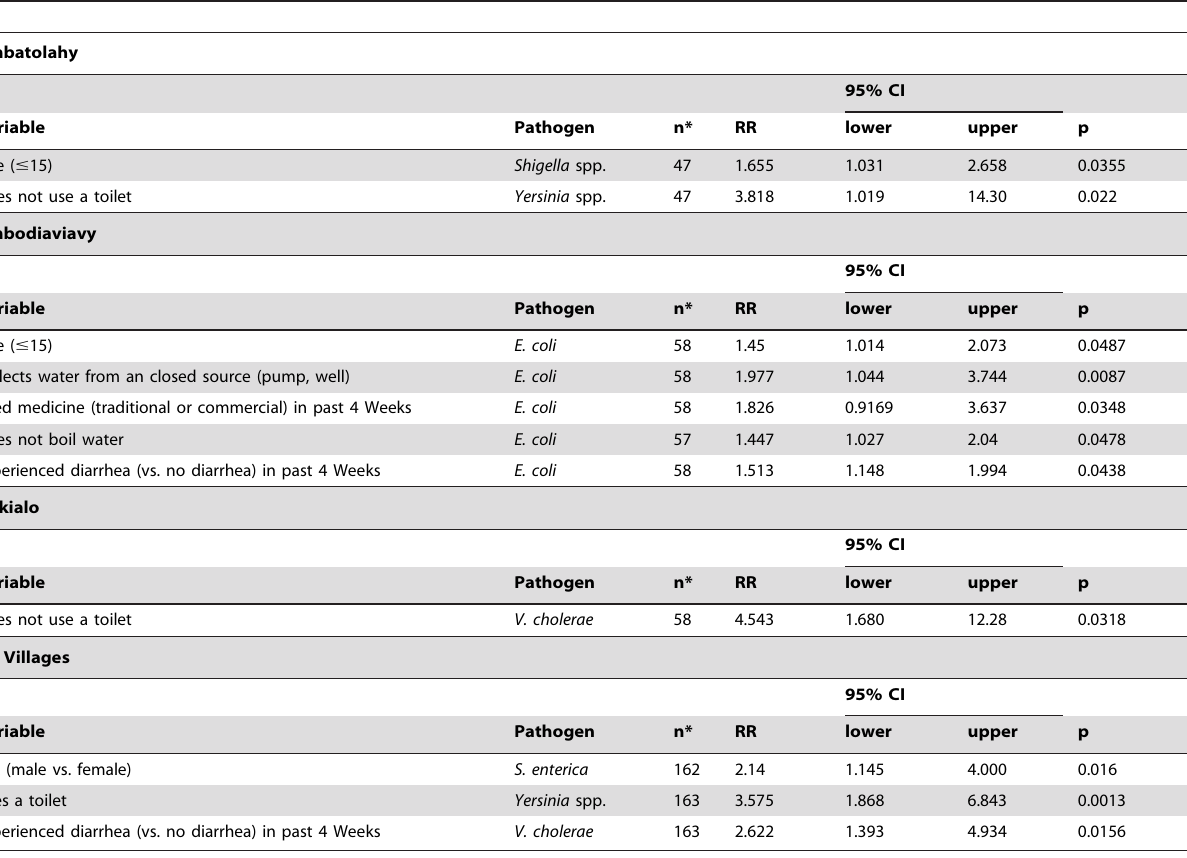
Table 6. Risk factors for infection with individual Enterobacteriaceae species in people living in villages in Southeast Madagascar.